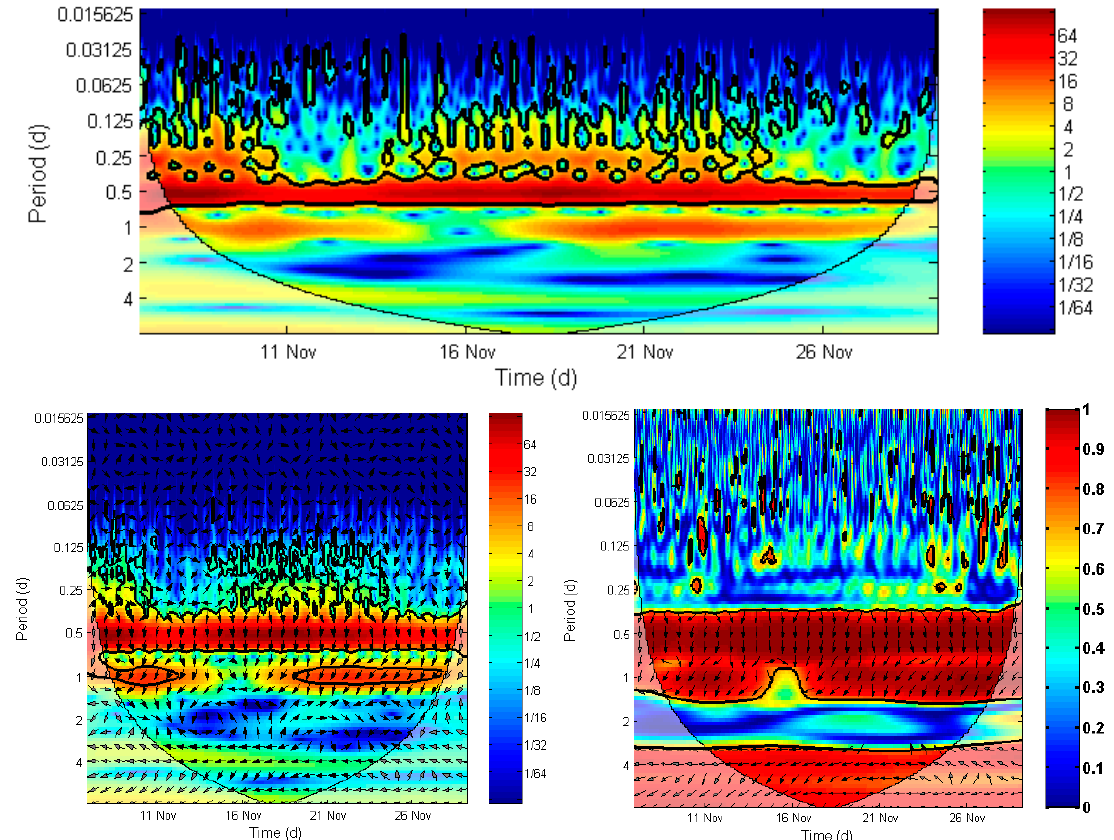
Figure 11. Wavelet analyses in the northern branch: (top) continuous wavelet transform; (bottom left) cross-wavelet transform; (bottom right) wavelet coherence. The black contours represent the 0.95 confidence level against red noise, and the cone of influence (COI) where edge e ff ects might distort the picture is shown as a lighter shade. The relative phase relationship is shown as arrows (with in-phase pointing right, anti-phase pointing left, and the first time series leading the second one by 90 ◦ pointing down). The wavelet power is log ( A 2 / v ), where A is the wavelet amplitude and v is the variance of the original tidal signals. The y -axis in the CWT and XWT is on a log scale.